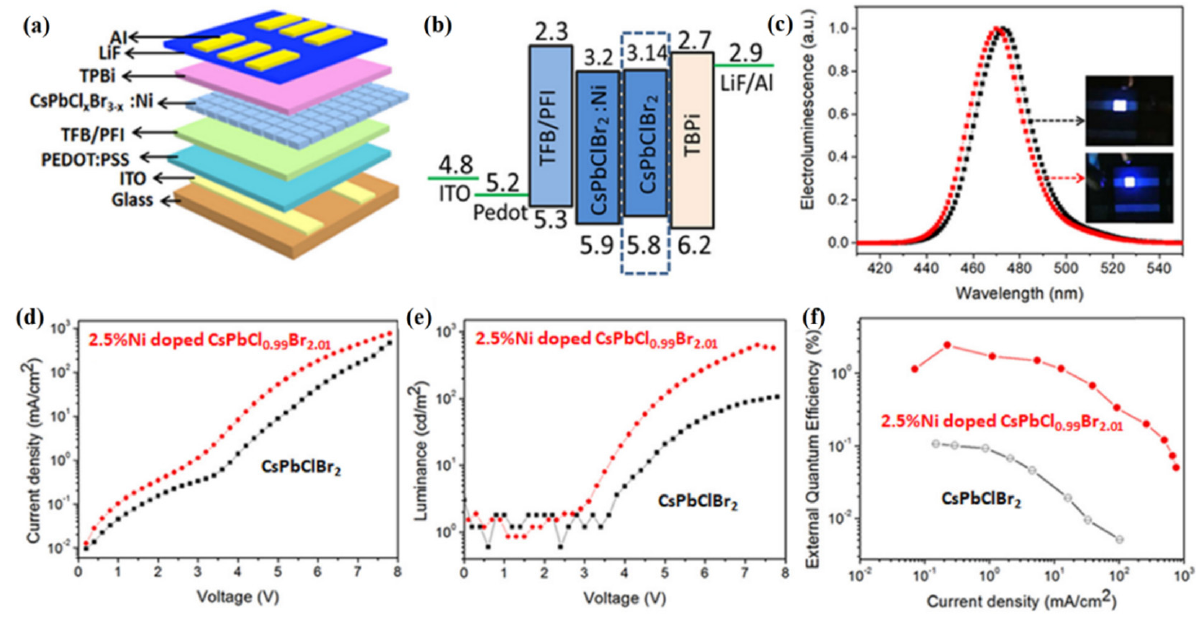
Figure 10. ( a , b ) Schematic diagram and band level of the PeQLED based on 2.5% Ni 2+ ion-doped CsPbCl 0.99 Br 2.01 QDs. ( c ) The EL spectra and photos of the PeQLED based on CsPbClBr 2 QDs (black) and 2.5% Ni 2+ —doped CsPbCl 0.99 Br 2.01 QDs (red), respectively. ( d – f ) Current density, luminance, and EQE of the corresponding devices. Adapted with permission from [130]. Copyright 2020, American Chemical Society.